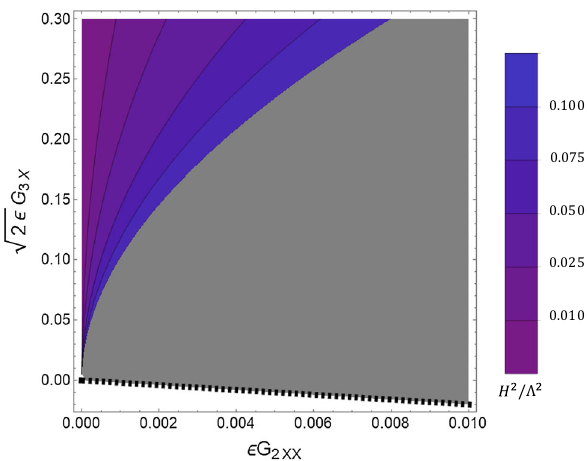
√ 2 (cid:9) G 3 X by Eqs.